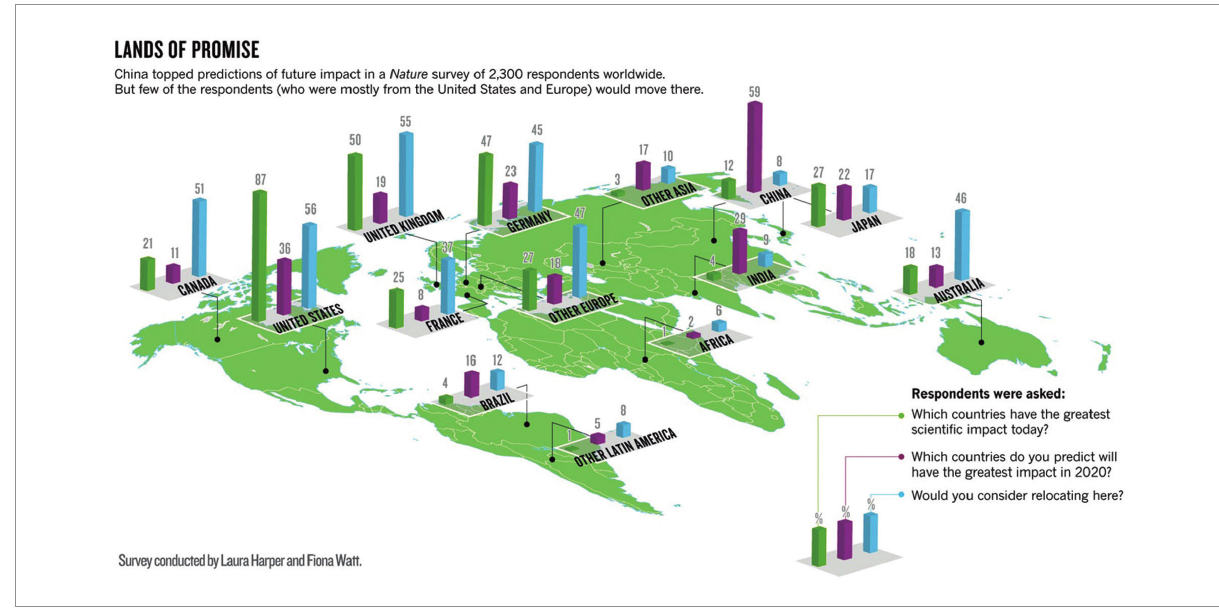
An assessment of current science impact (green), predicted impact by 2020 (purple) and attractiveness as a science destination for the